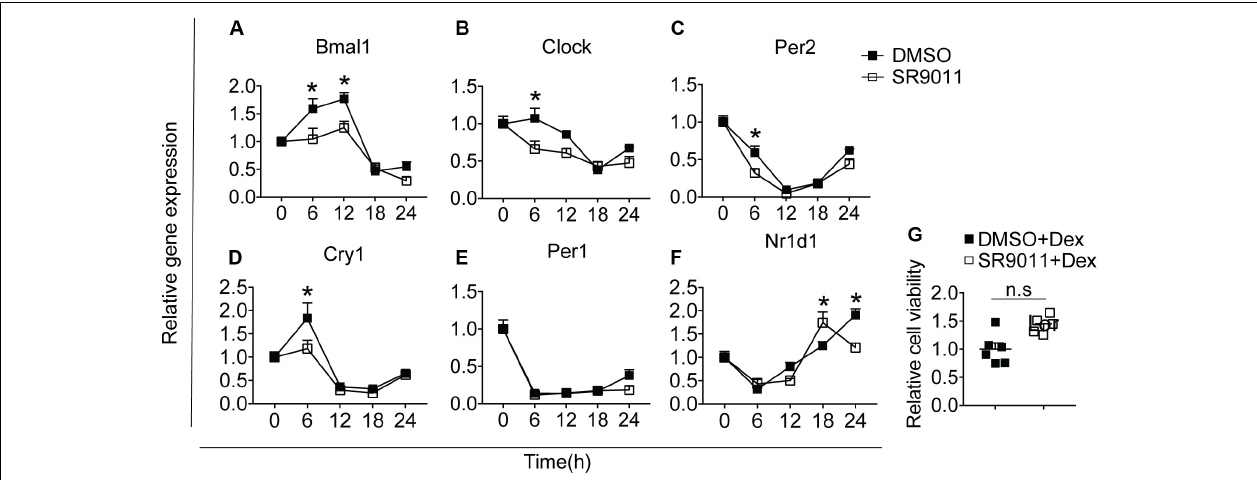
FIGURE 2 | SR9011 disrupts clock gene expression in microglia. Rhythmic and relative gene expression of clock genes in primary microglia. Cells were treated with dexamethasone for 2 h followed by SR9011 or DMSO and were harvested at the indicated time points ( n = 4 per group, per time point). (A–F) Clock gene expression is altered by SR9011 treatment compared to DMSO (control). SR9011 disrupted the rhythmic expression of Bmal1 and Clock , and caused a shift in the acrophase of Per2 rhythm, as analyzed by JTK_Cycle. (G) Cell viability of primary microglia was not affected by the 24-h SR9011 treatment with dexamethasone. Data are presented as means ± SEM. p < 0.05* vs. DMSO group was determined using Two-way ANOVA followed by Bonferroni’s post hoc test and multiple comparison.